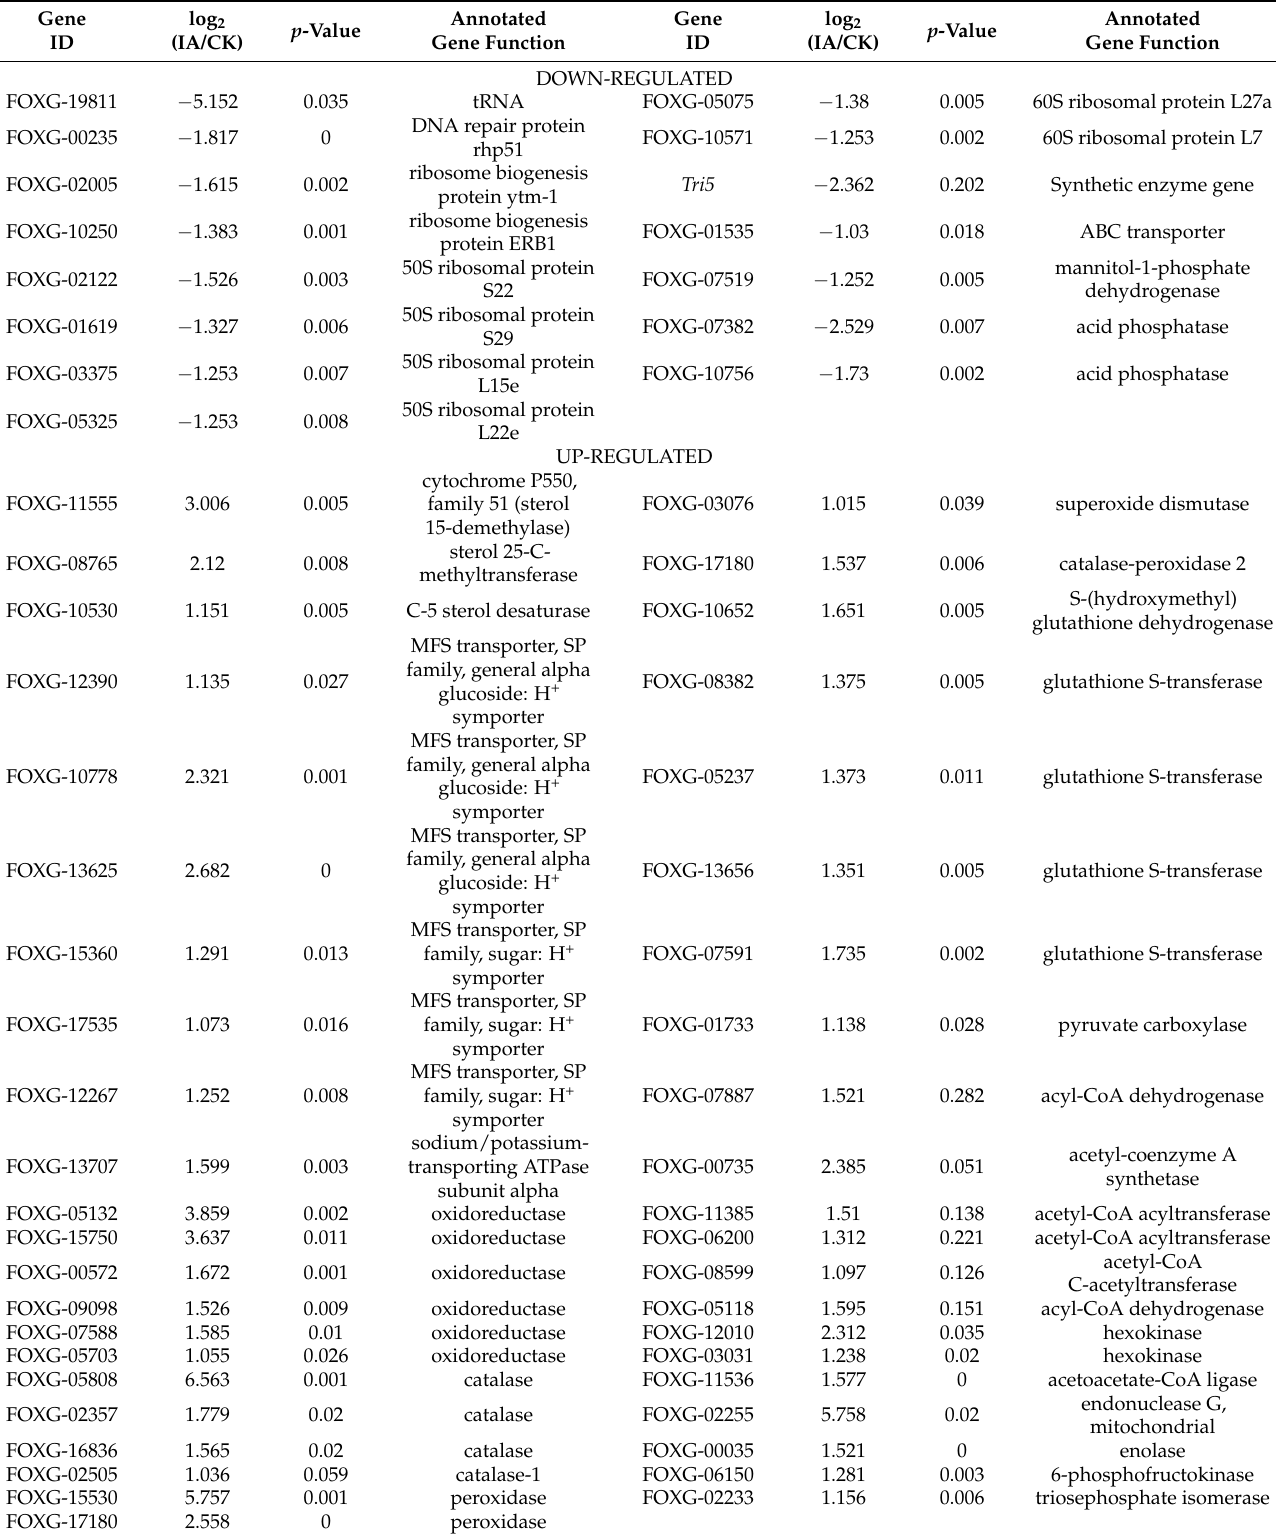
Table 3. Differentially expressed genes in F. oxysporum exposed to 50 µ g/mL iturin A compared with the